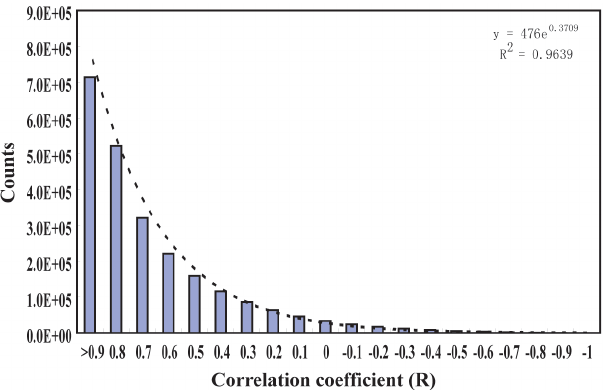
Figure 7. The histogram of distribution probability at different cor- relation coefficients before and after global earthquakes (in the right corner of the panel, the exponential decay has been fitted between the counts (variable y) and different coefficient scales (variable x) ; furthermore, the correlation coefficient R has been